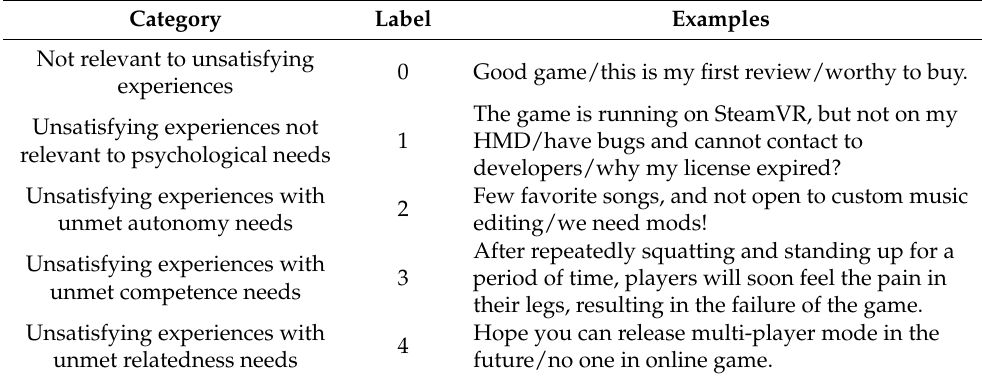
Table A1. Annotation